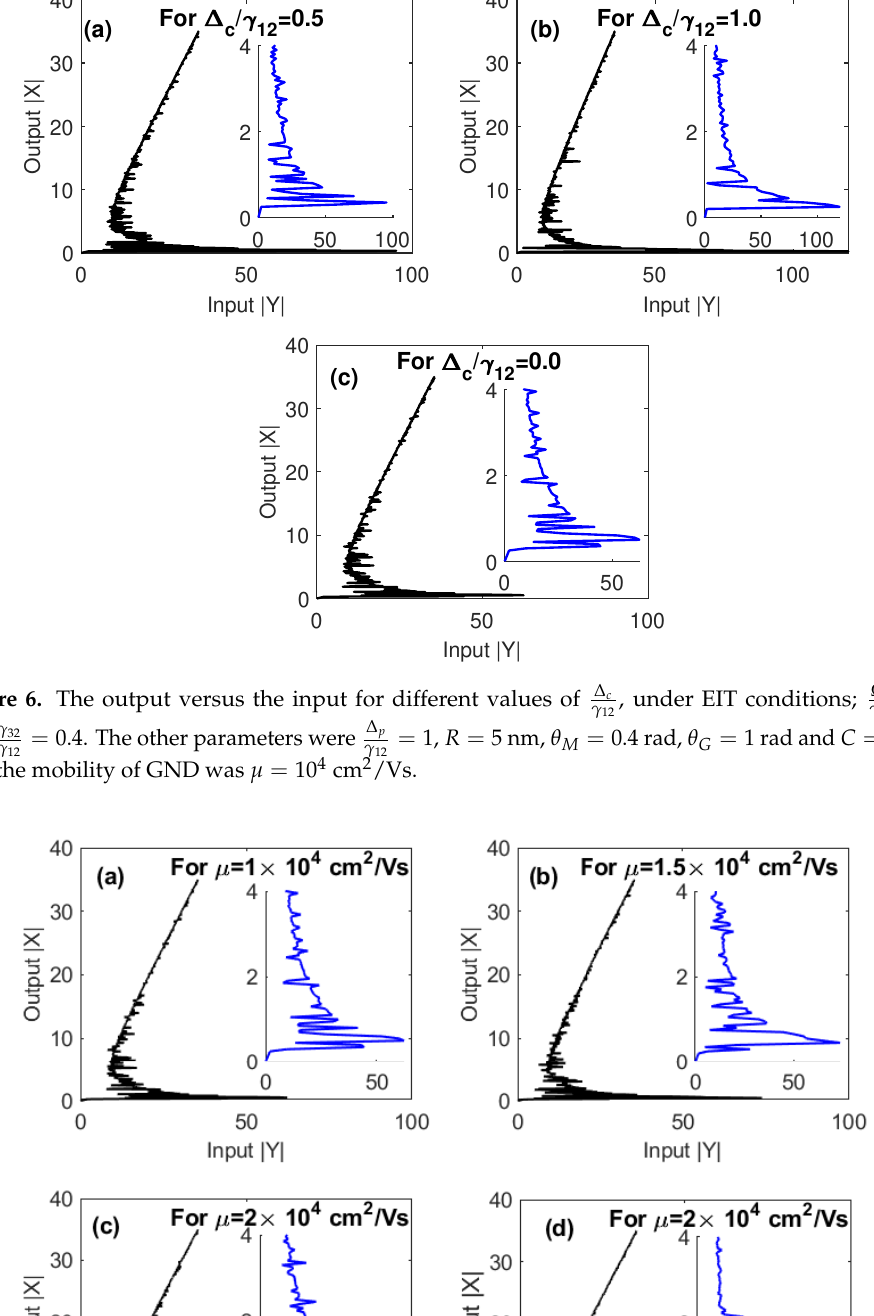
Figure 7. The output versus the input for different values of the mobility of GND under EIT conditions; Ω = 2, and γ 32 = 0.4. The other parameters were c γ 12 γ 12 θ M = 0.4 rad, θ G = 1 rad and C =